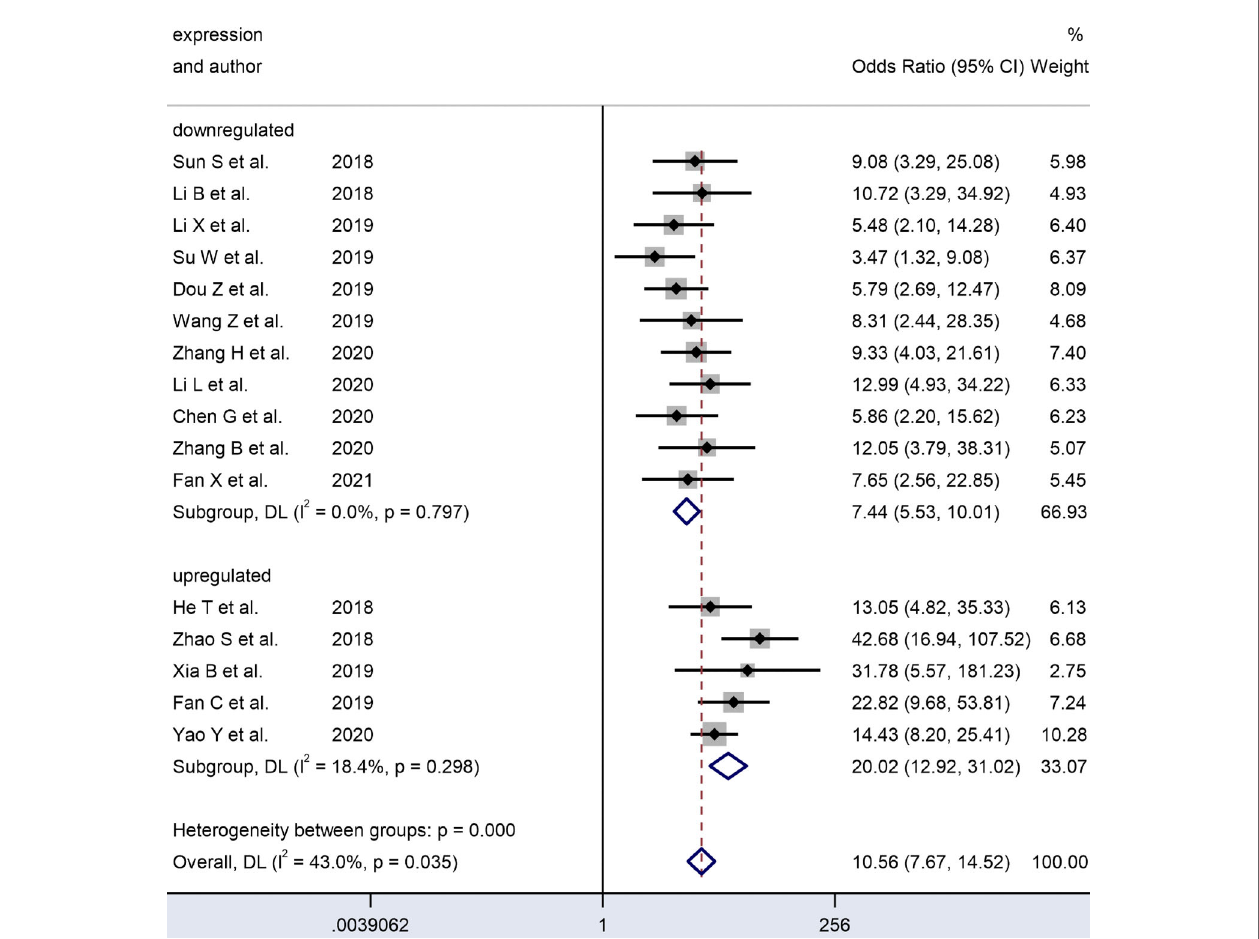
FIGURE 6 | Forest plots of subgroup analysis of the combined ORs with 95%CIs according to expression status of circRNAs in patients with